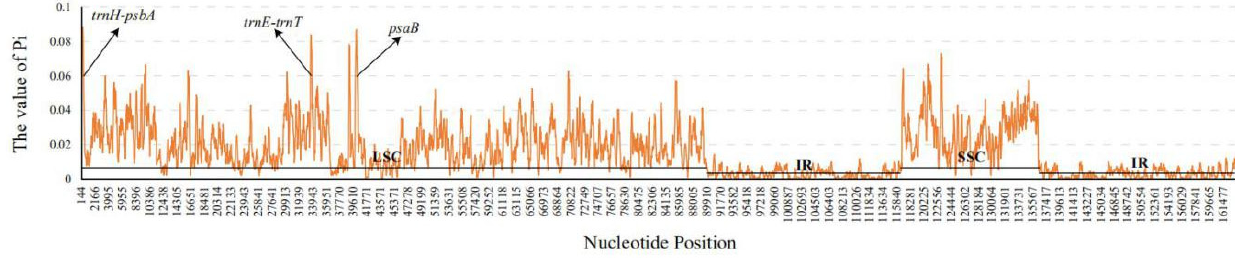
Figure 5. A sliding window analysis of nucleotide variability (Pi) values. X-axis: position of the midpoint of a window, Y-axis: nucleotide diversity of each window.